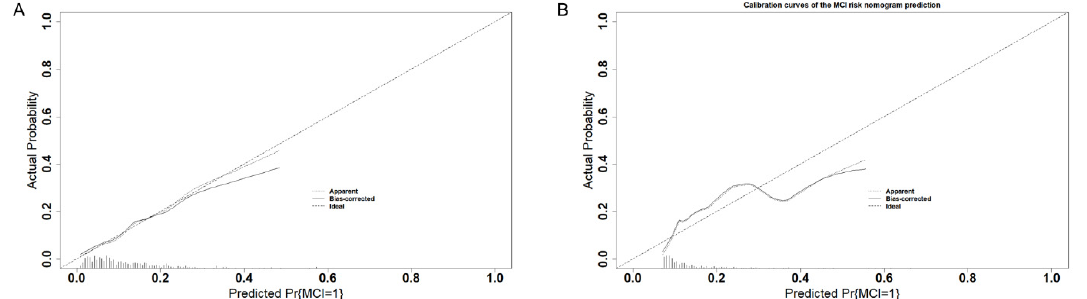
Figure 5. Calibration curves of the MCI risk nomogram prediction. The y ‐ axis indicates the actual diagnosed MCI. The x ‐ axis indicates the predicted risk of MCI. The diagonal dotted line indicates perfect prediction by an ideal model. The solid line represents the performance of the training set ( A ) and validation set ( B ); a closer fit to the diagonal dotted line represents a better prediction.